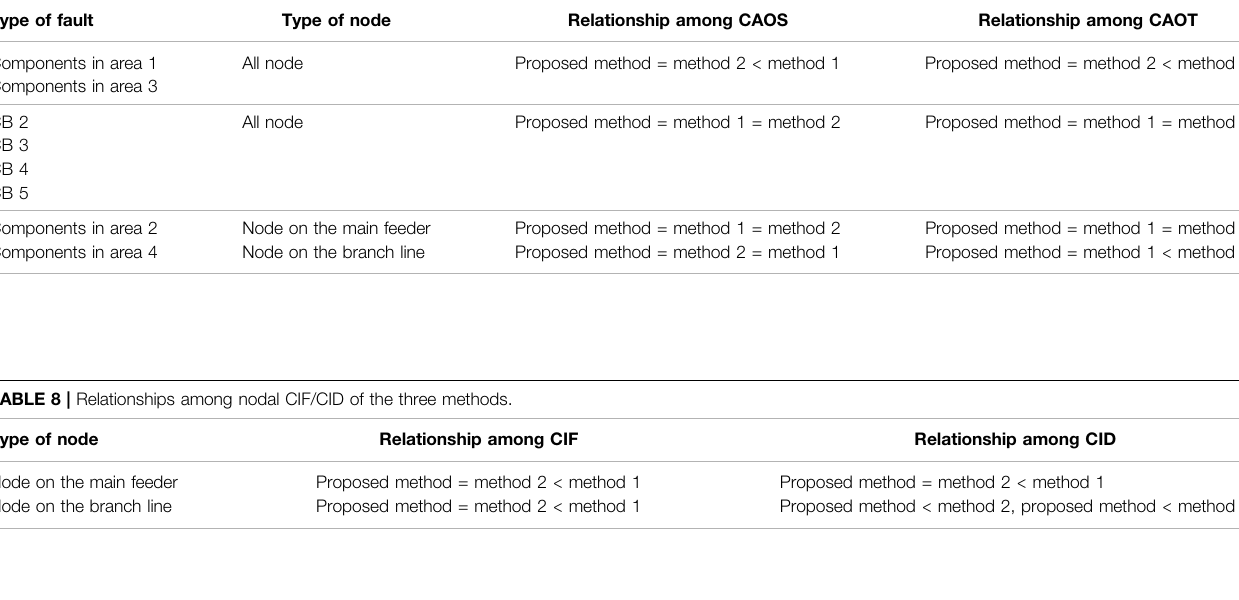
TABLE 7 | Relationships among nodal CAOS/CAOT of the three methods under various types of faults.